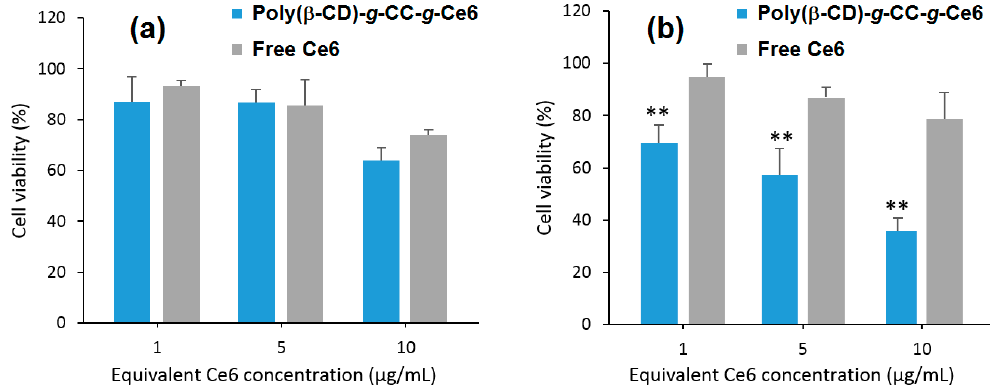
Figure 48. Photoinduced mortality of the human nasopharyngeal epidermal carcinoma (KB) cell line treated with Poly( β -CD)- g -CC- g -Ce6 NPs (equivalent Ce6 1–10 µ g/mL) or free ZnPc (1–10 µ g/mL) upon irradiation ( λ = 670 nm, 5.2 mW/cm 2 for 10 min) at ( a ) pH 7.4 and ( b ) pH 6.5. ** p < 0.01 compared to free Ce6. Results are expressed as the mean of seven measurements with the vertical bar showing SD. Adapted from Lee; Oh; Youn; Lee [179].